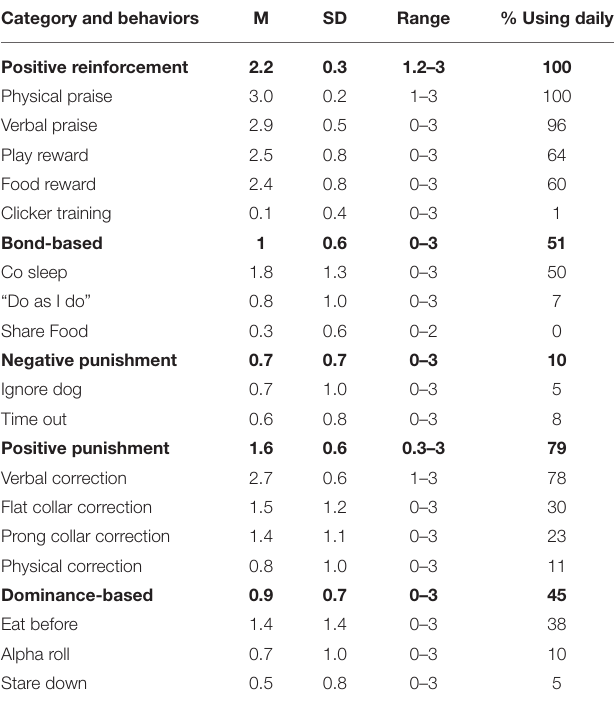
TABLE 1 | Handler Training